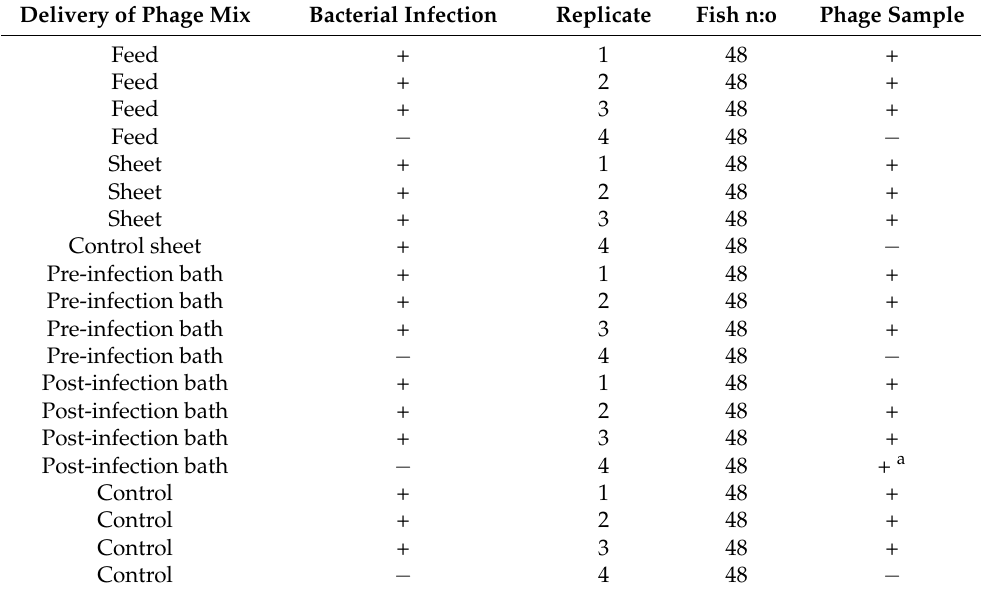
Table 4. Setup of experiment III. First group (feed) received feed coated with a phage mix (FCOV-F27 and FCL-2), daily for 7 days at 2% of body weight. Phage mix-coated plastic sheets were placed in tanks 7 days before bacterial infection for two weeks. One aquarium of the second group received a control sheet with no phage coating (control sheet). A third group of fish was placed one day before bacterial infection in a 2-h phage mix bath (pre-infection bath). The fish were infected with a bacterium mixture (FCO-F2 and B185) on day 8 in a bath for 2 h. A fourth group received a